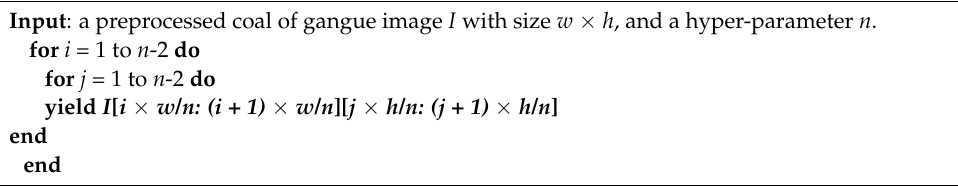
Algorithm 1. Local sampling of a coal or gangue image